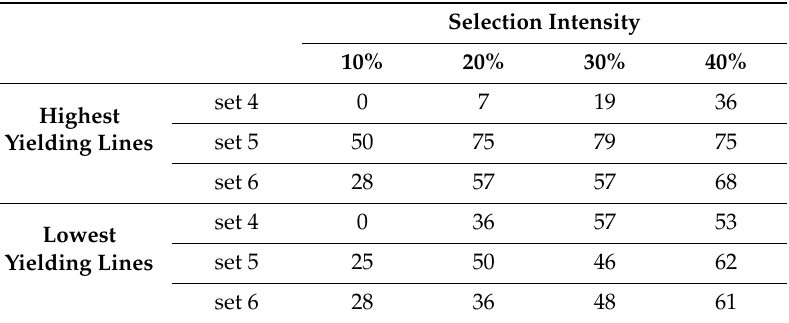
Table 5. Percentage of correctly selected highest and lowest yielding wheat breeding lines at di ff erent selection intensities (10–40%), for the di ff erent data sets. Prediction accuracy for yield when 50% of each set predicted the other 50% was set 4 = 0.13, set 5 = 0.65 and set 6 =